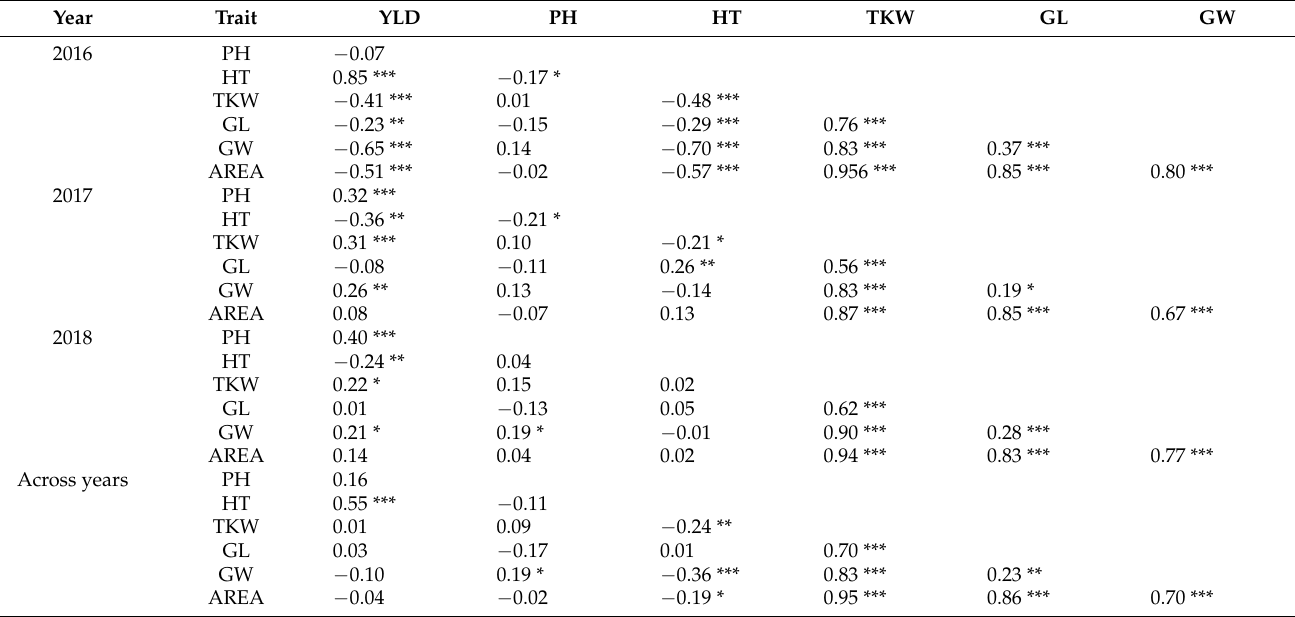
localized on the A genome with a total length of 1145.3 cM, whereas 3049 were mapped on the B genome (total length 1062.7 cM). The entire map covered 2207.9 cM with an average chromosome length of 157.7 cM. The lengths of individual chromosomes varied from 73.3 cM (chromosome 5B) to 197.2 cM (chromosome 7A). The SNP markers were generally well distributed throughout the genome, although some chromosomes exhibited higher densities. The overall SNP density was 2.3 markers/cM, with a maximum of 3.8 for chromosome 1B and a minimum of 1.2 for chromosome 4A. Table 3. Pearson correlation coefficients ( r ) among grain yield (YLD), plant height (PH), heading time (HT), thousand kernel weight (TKW), grain length (GL), grain width (GW), grain area (AREA) in the Liberdur x Anco Marzio RIL mapping population evaluated for three years (2016, 2017 and 2018) and across year.